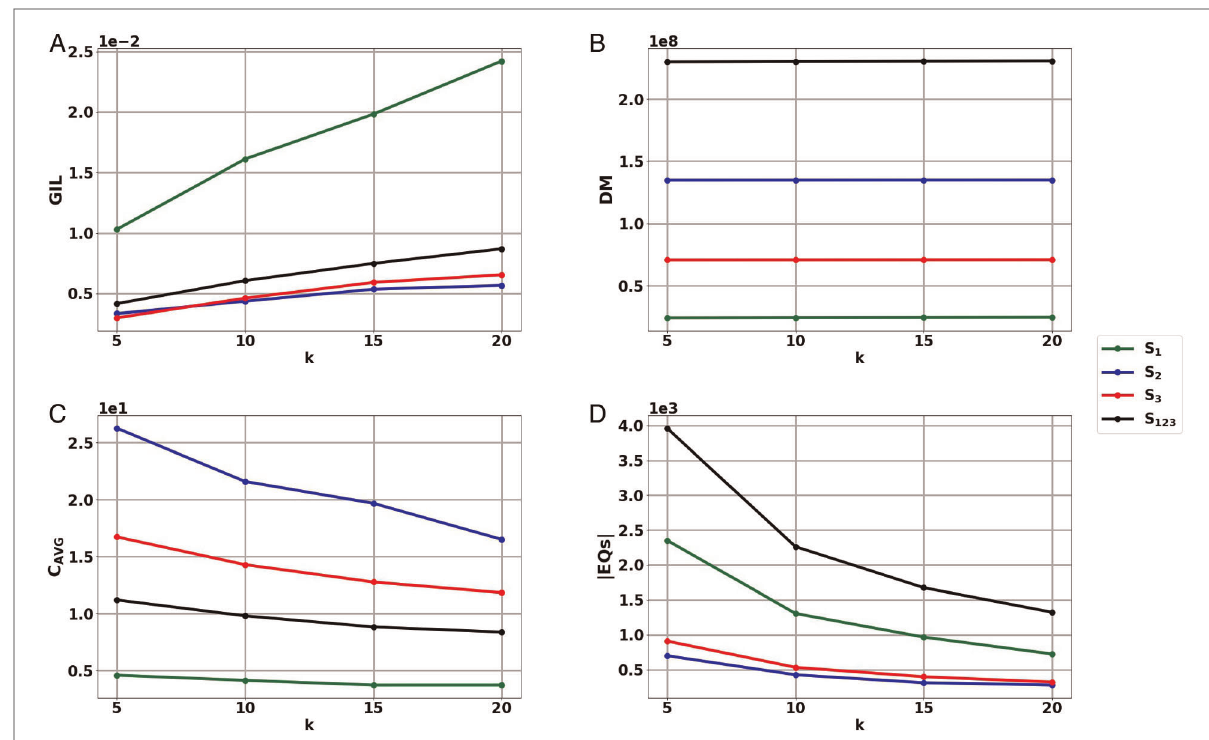
FIGURE 2 Results of the information loss metrics ( A ) Generalized Information Loss (GIL), ( B ) Discernibility Metric (DM) and ( D ) Average Equivalence Class size (C AVG ), as well as ( D ) the number of Equivalence Classes (|EQs|) of the harmonized, anonymized data sets S 1 , S 2 , S 3 , S 123 for the tested k values. The results are depicted in scienti fi c